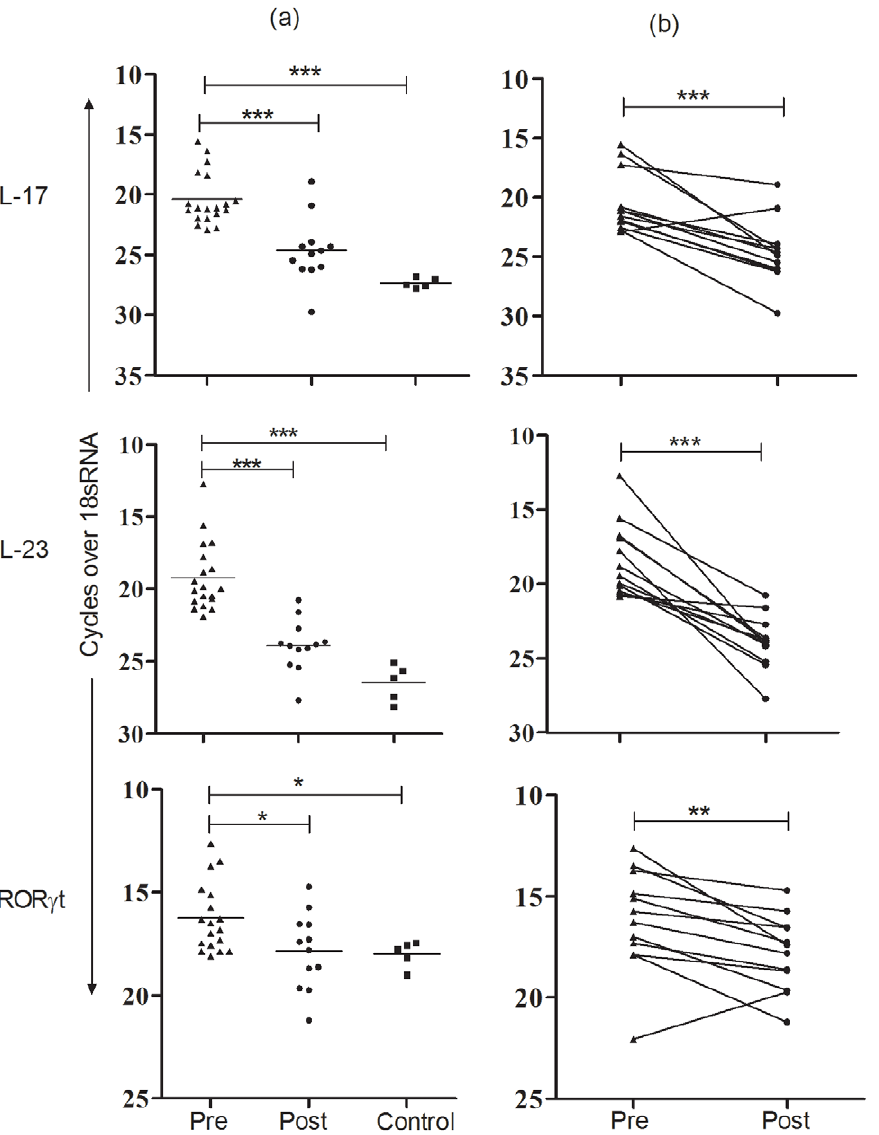
Figure 2. mRNA expression of Th17 markers in PKDL. Relative mRNA levels of IL-17, IL-23 and ROR c t was determined by QPCR in (a) tissues lesions at pretreatment (n=19), post treatment (n=12), or control tissues (n=5) or (b) in paired samples (n=12). The Y axis represents the number of cycles over endogenous control (18sRNA) required to detect the gene expression of interest. *P , 0.05, **P , 0.01, and ***P , 0.001.